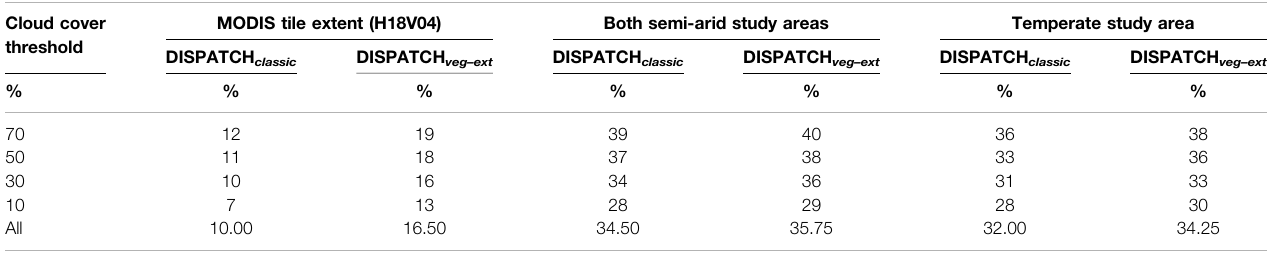
TABLE 1 | Percentage of valid pixels within the 1 km resolution disaggregated SM images using DISPATCH classic and DISPATCH veg – ext algorithm for i) the entire MODIS tile extent H18V04, ii) the union of both semi-arid areas and iii) the temperate study area separately, for different cloud cover thresholds in 2017. Cloud cover MODIS tile extent (H18V04) threshold